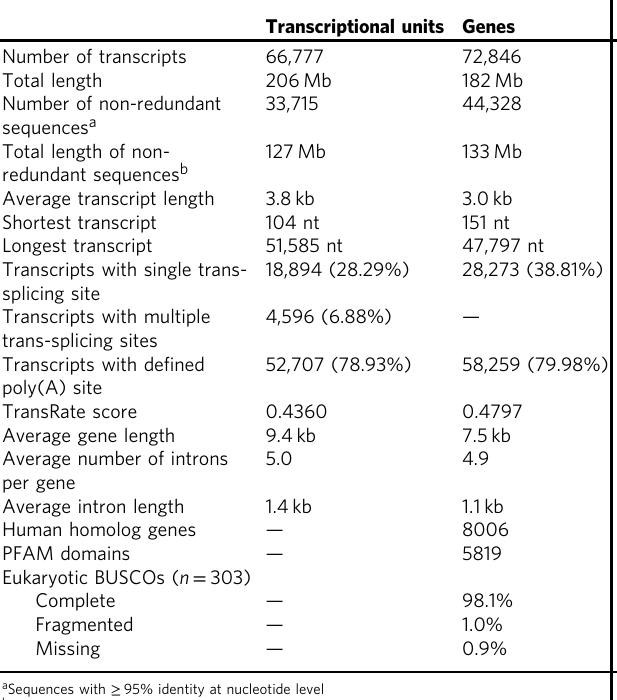
Table 3 Characteristics of Mlig_RNA_3_7_DV.v1 (Table 1), and transgenic line NL24 expressing codon-optimized transcriptome assembly mNeonGreen (oNeonGreen) in testes and codon-optimized mScarlet-I (oScarlet) in ovaries was established (Fig. 3e), Transcriptional units demonstrating the feasibility of multi-color reporters in M . lig- nano . The successful generation of stable transgenic reporter lines